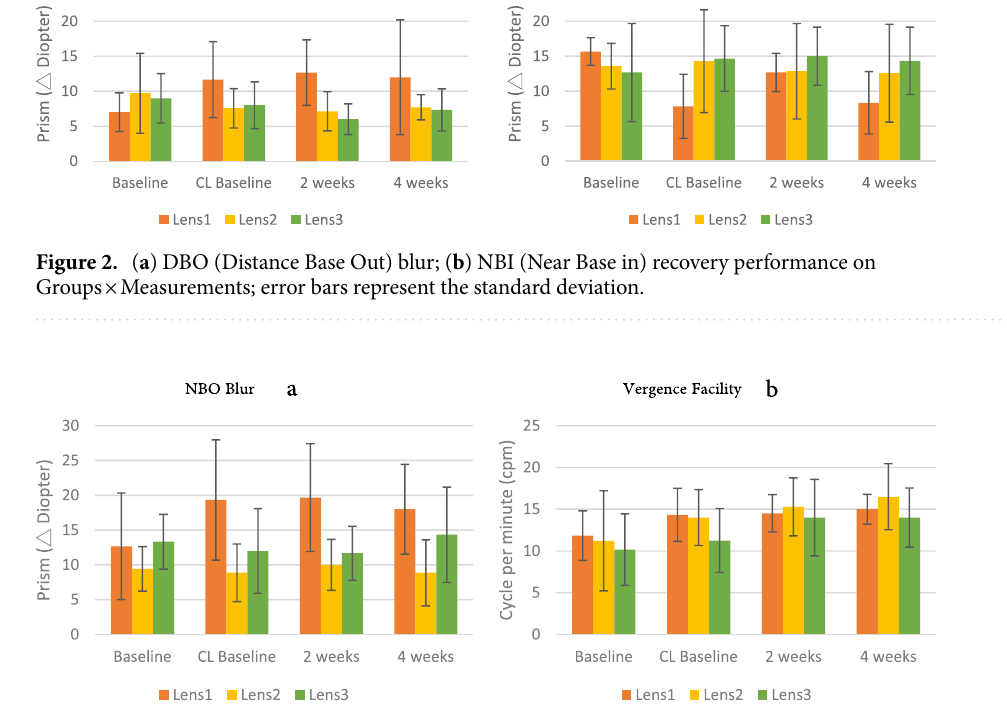
Figure 3. ( a ) NBO (Near Base Out) blur, ( b ) vergence facility performance on Groups × Measurements; error bars represent the standard